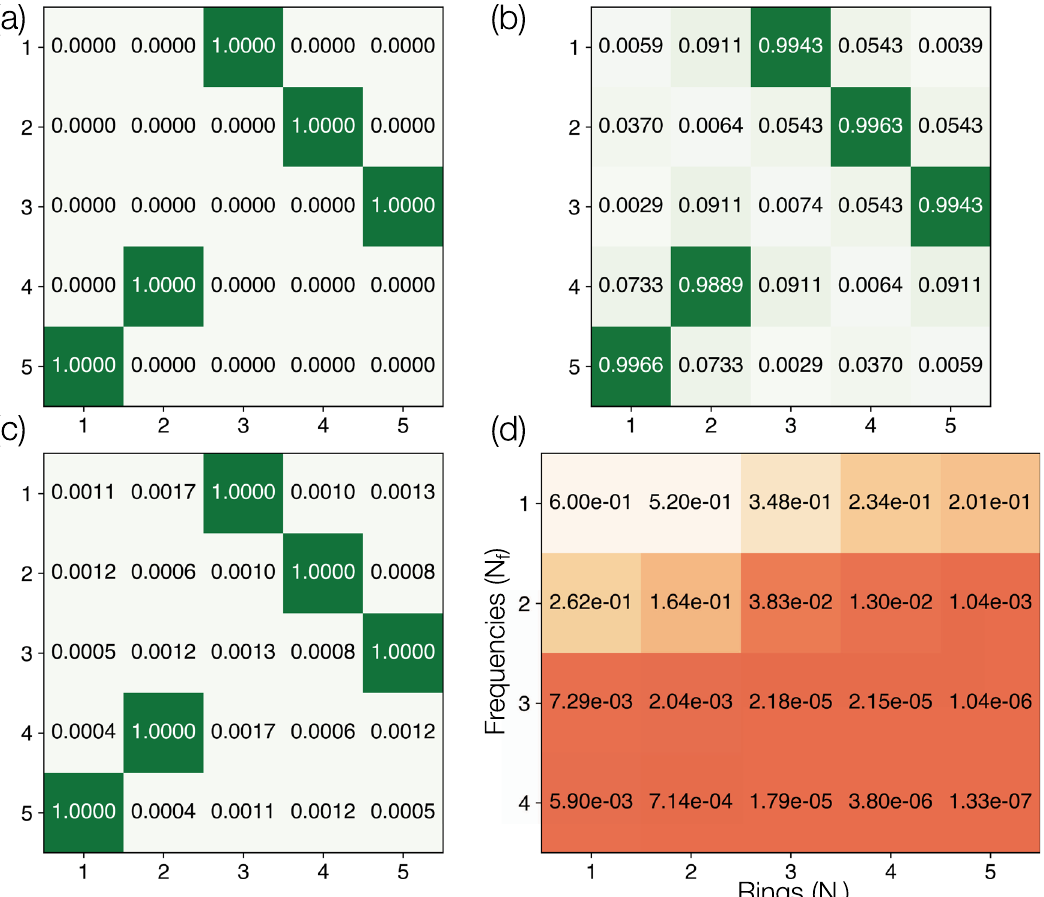
Fig. 4 Implementing elementwise amplitudes of a matrix. a A 5 × 5 permutation matrix to be implemented by the ring-waveguide system. The amplitudes of the matrix elements are indicated along with a green colormap. Element-wise amplitudes of the optimized result using four modulation tones ( N f = 4) and b one ring ( N r = 1), achieving a fi delity of 1 − 5.9 × 10 − 3 , and c four rings ( N r = 4), achieving a fi delity of 1 − 3.8 × 10 − 6 . d One minus the maximum fi delities achieved by the inverse-design algorithm as a function of N N r and f . A value closer to zero indicates a better performance. Modulation parameters for c are provided in Supplementary Note